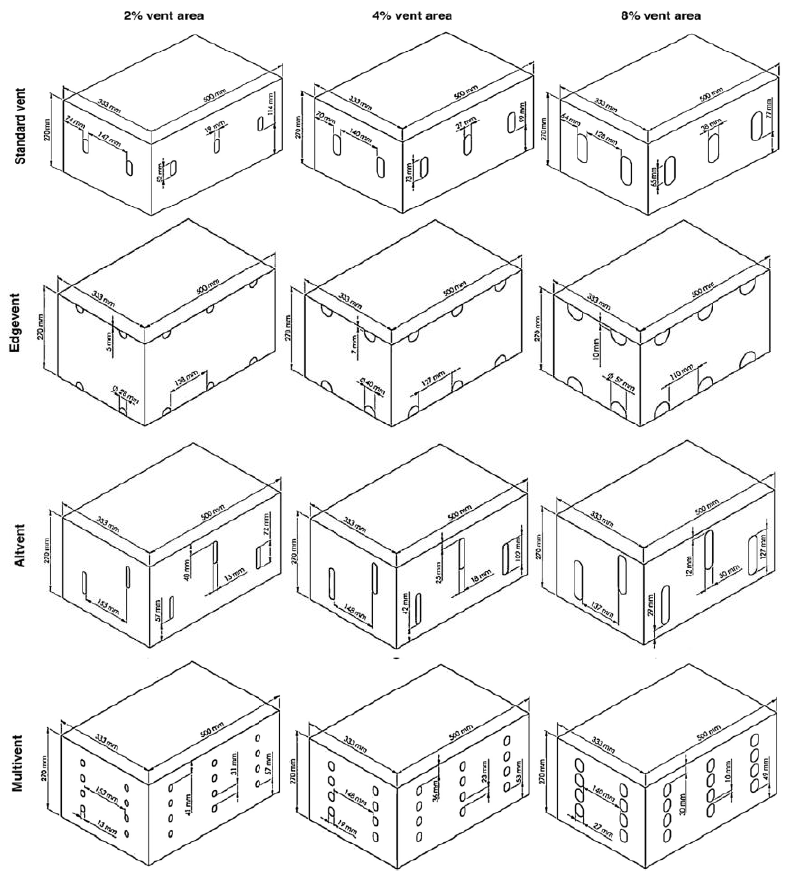
Figure 9. Different designs of vent holes